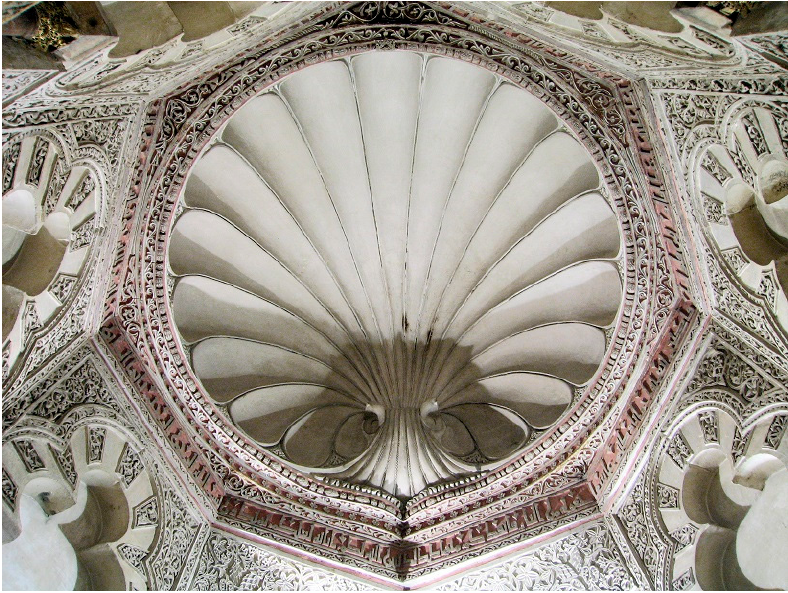
Figure 9. Great Mosque of Cordoba. Scallop-shell vault of the caliphal mihrab (10th century). © Photo took by